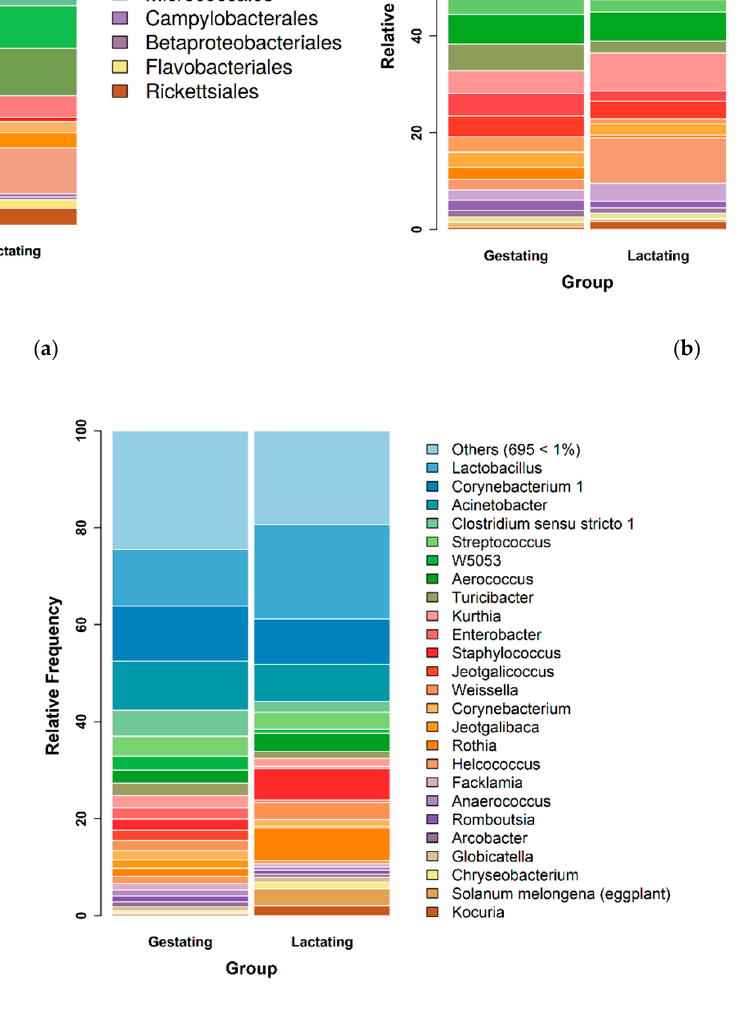
Figure 4. Bacterial microbiota structure of the oral fluid in gestating ( n = 10) and lactating ( n = 9) sows. ( a ). Bacterial microbiota structure at the order level of the oral fluid in gestating ( n = 10) and lactating ( n = 9) sows. Only the bacterial orders that shared >1% abundance are indicated by different colors, while the others were grouped together. ( b ) Bacterial microbiota structure at the family level of the oral fluid in gestating ( n = 10) and lactating ( n = 9) sows. Only the bacterial families that shared >1% abundance are indicated by different colors, while the others were grouped together. ( c ) Bacterial microbiota structure at the genus level of the oral fluid in gestating ( n = 10) and lactating ( n = 9) sows. Only the bacterial genera that shared >1% abundance are indicated by different colors, while the others were grouped together.